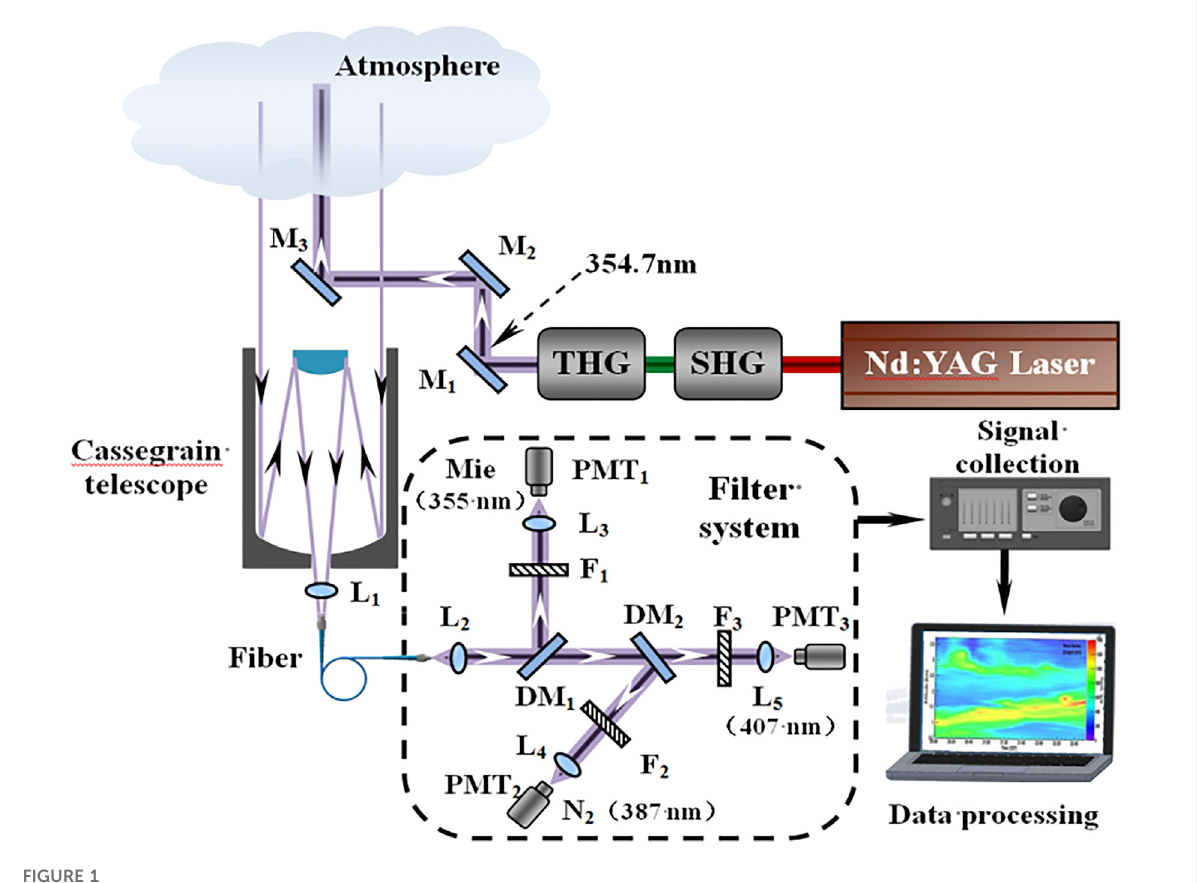
FIGURE 1 A schematic diagram of Raman lidar